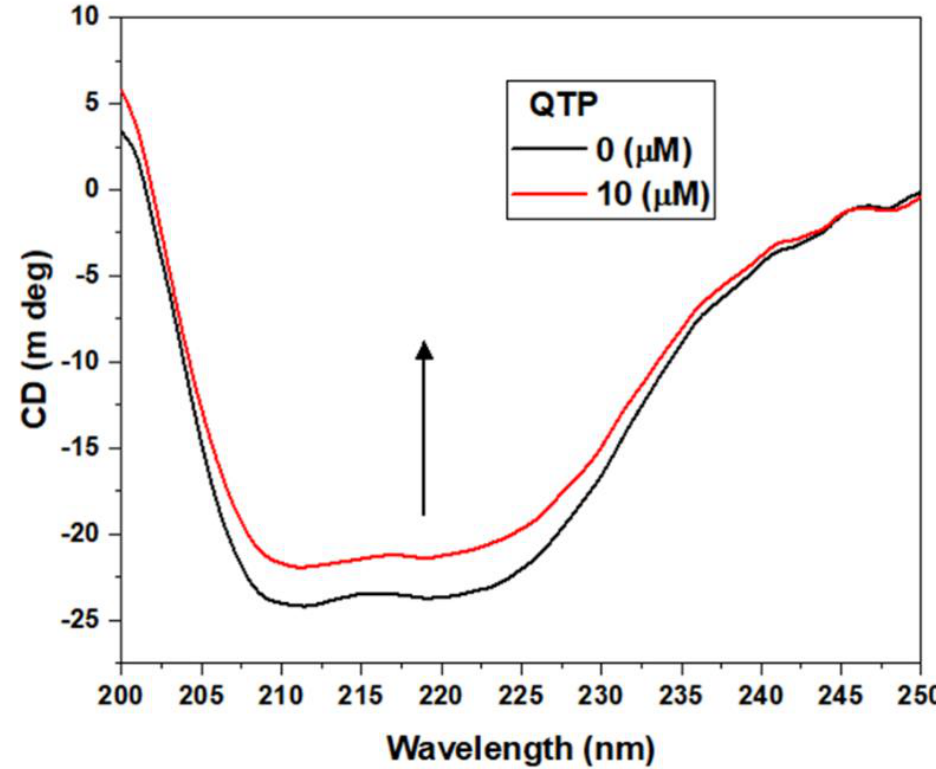
Figure 6. Circular dichroism spectra of HSA (5 µ M) in the absence and presence of QTP (10 µ M).